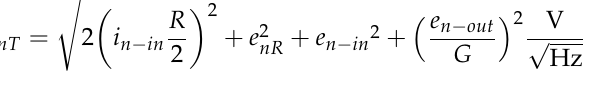
Table 2. Scaling analysis of µSCM and a summary of the key parameters’ exponents for sensitivity ( S e ), e nR, and SNR n ( T : temperature; ρ : material resistivity; h : track thickness).